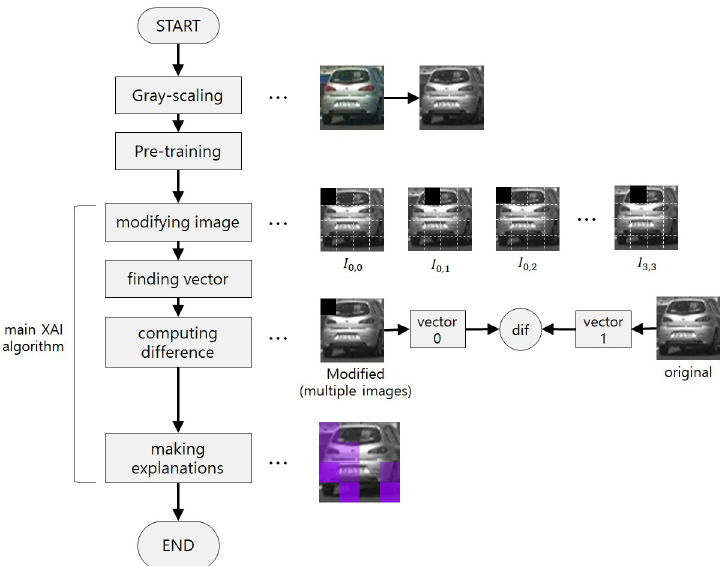
Fig 1. Describes the overall algorithm of our methodology. First, gray-scale images (Gray-scaling), and then pre- train the CNN model (Pre-training), then perform the main XAI algorithm. It contains four stages(steps), that is, modifying image , finding vector , computing difference , and making explanations